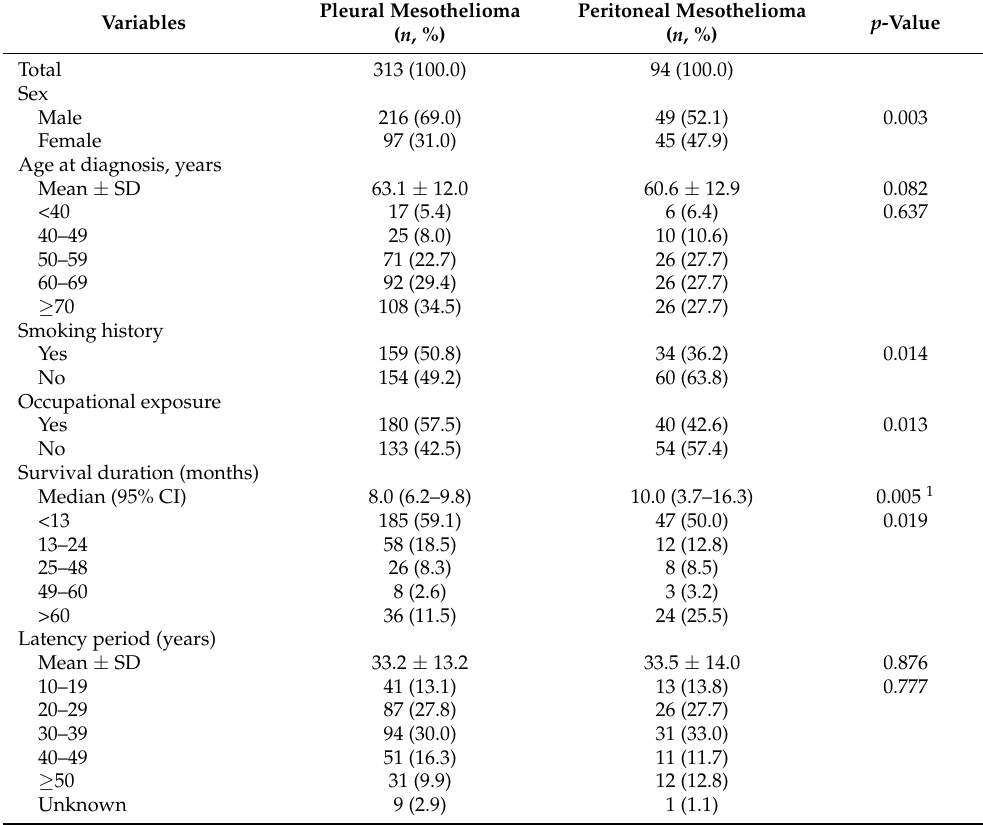
Table 2. Comparison of malignant mesothelioma by site of onset ( n =